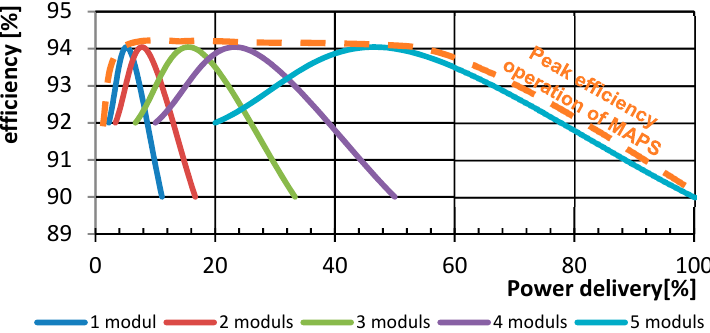
Figure 6. Efficiency curves of parallel configuration of five DC/DC stages.